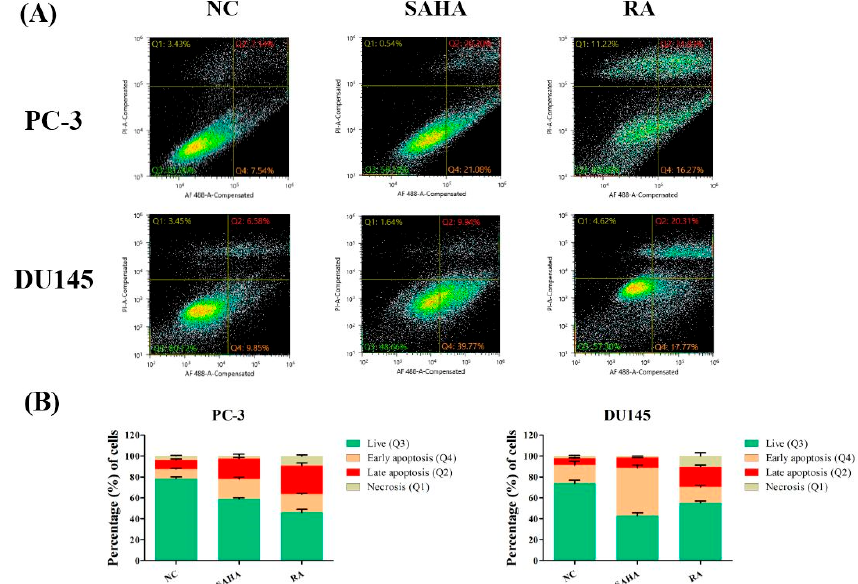
Figure 3. Effects of SAHA and RA on the apoptotic events in PC-3 and DU145 cell lines. ( A ) After both cell lines were seeded at 7 × 10 5 cells in cell culture dishes and treated with media containing NC (DMSO), SAHA (1 μ M) and RA (200 μ M), Annexin V assay was conducted. ( B ) The apoptotic cells at each stage were analyzed and quantified by using the flow cytometry. Q1, Q2, Q3 and Q4 indicate necrosis, late apoptosis, live and early apoptosis, respectively.